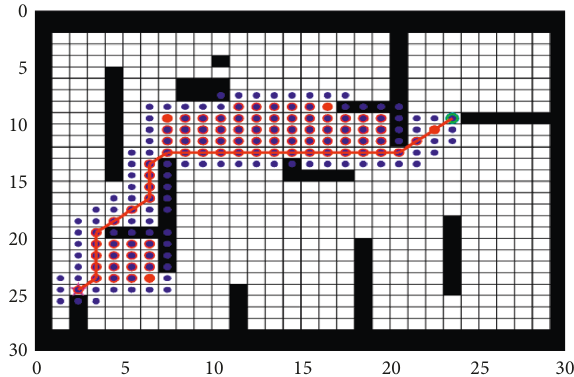
Figure 5: 3 ∗ 3 Search neighborhood planning result.